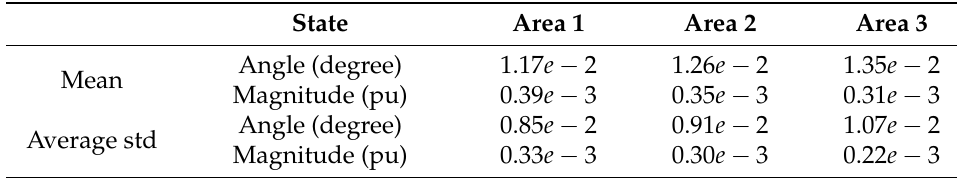
Figure 8. Per area error curves on the IEEE -118 bus system 3 regions. Table 3. Statistic metric per state per area on IEEE -118.